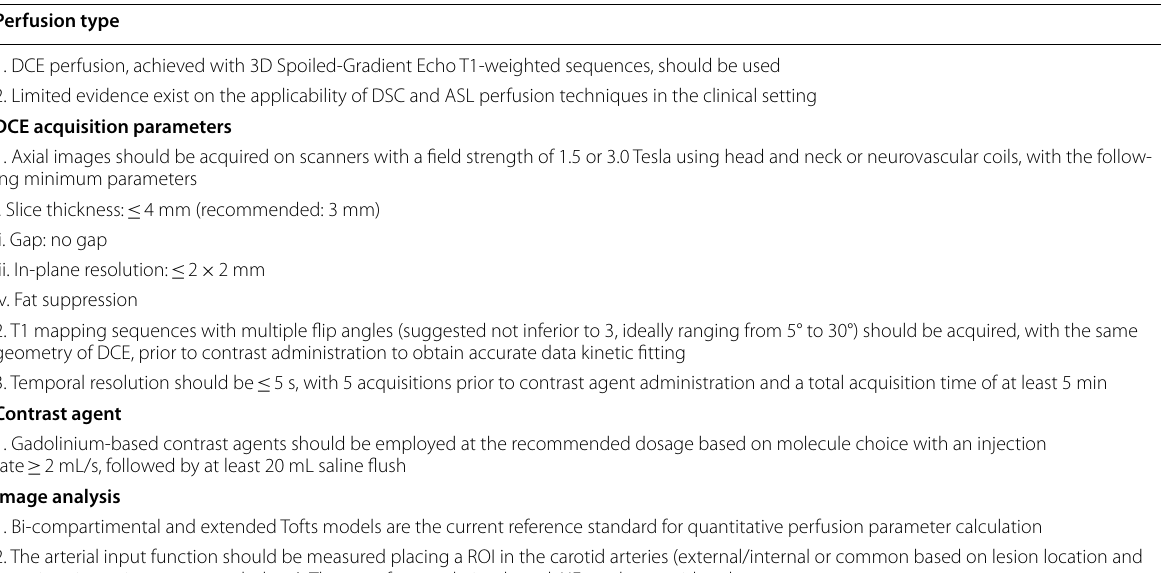
Table 2 Acquisition technique recommendations for PWI in HNSCC Perfusion